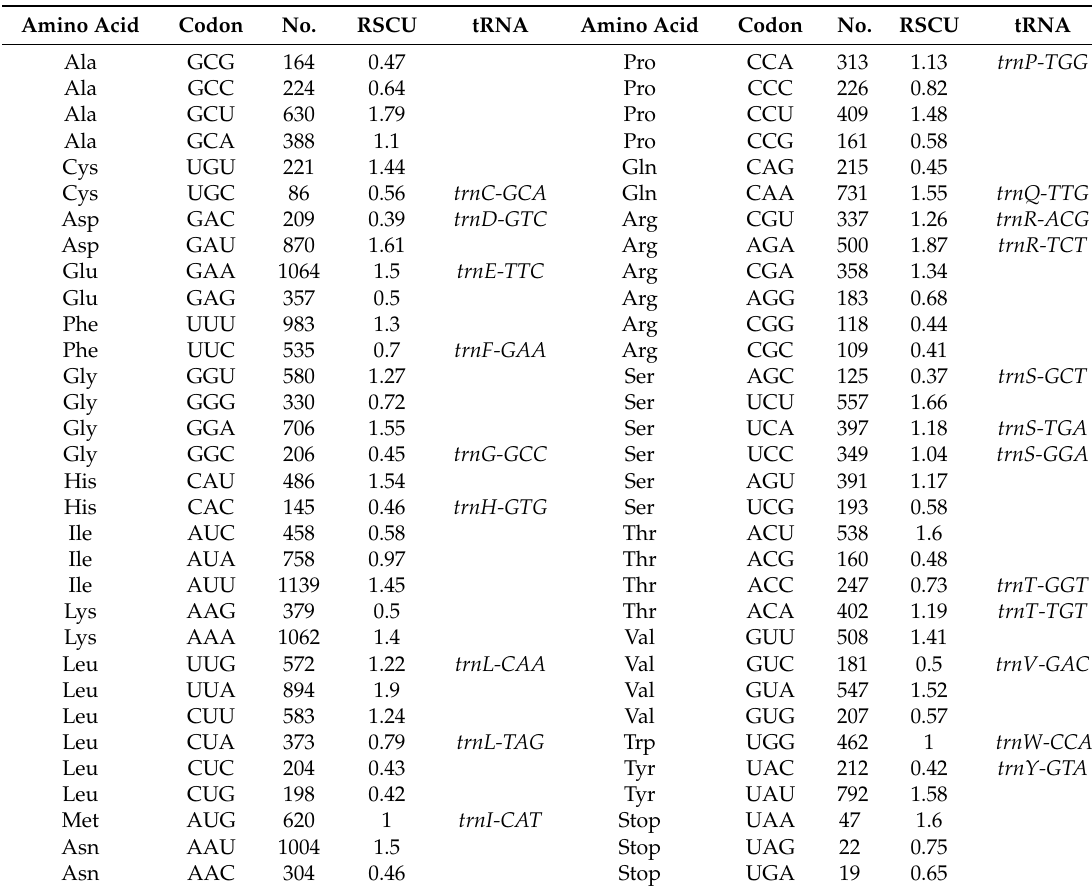
Table A2. Codon-anticodon recognition patterns and codon usage of the Q. acutissima chloroplast genome. Amino